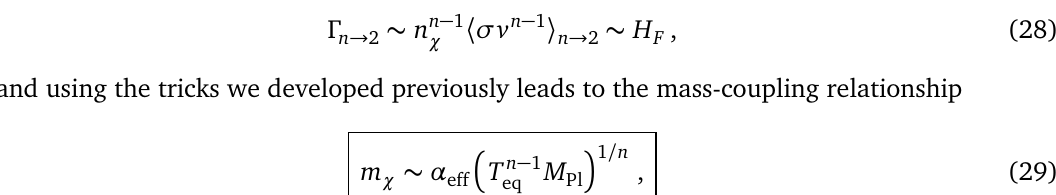
Figure 2: Left: Topologies for 3 → 2 interactions in the toy Z Cooling versus